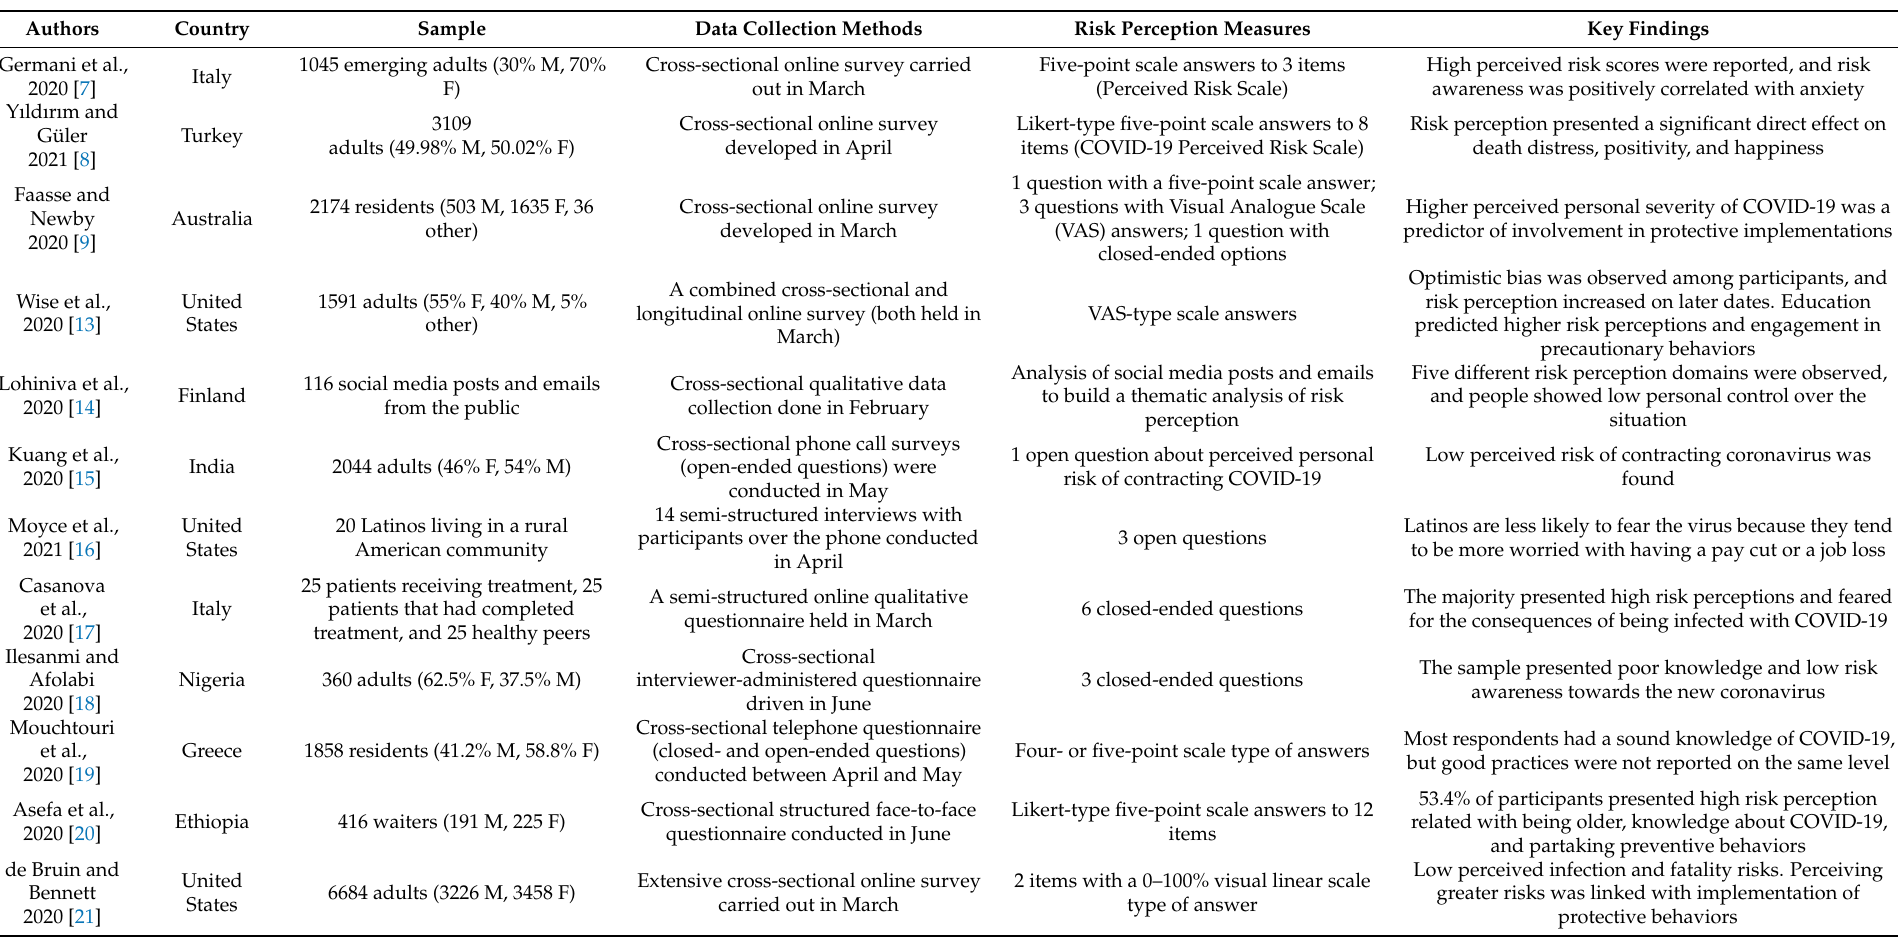
Table A1. Comparative appraisal of the